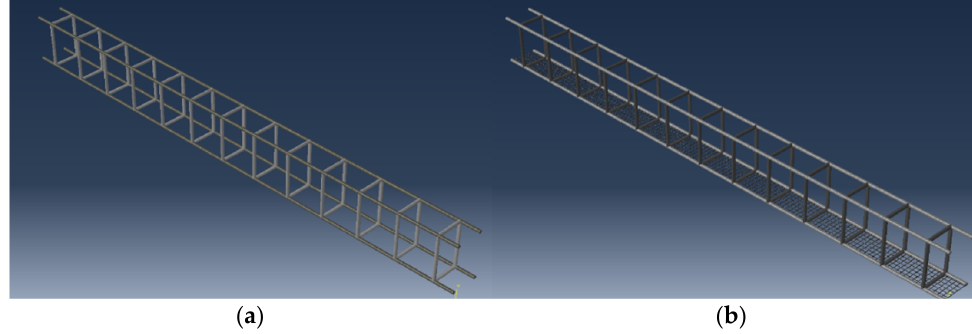
Figure 17. ABAQUS Reinforcement Model. ( a ) Steel Bars without Mesh Reinforcement; ( b ) Steel Bars with mesh reinforcement.